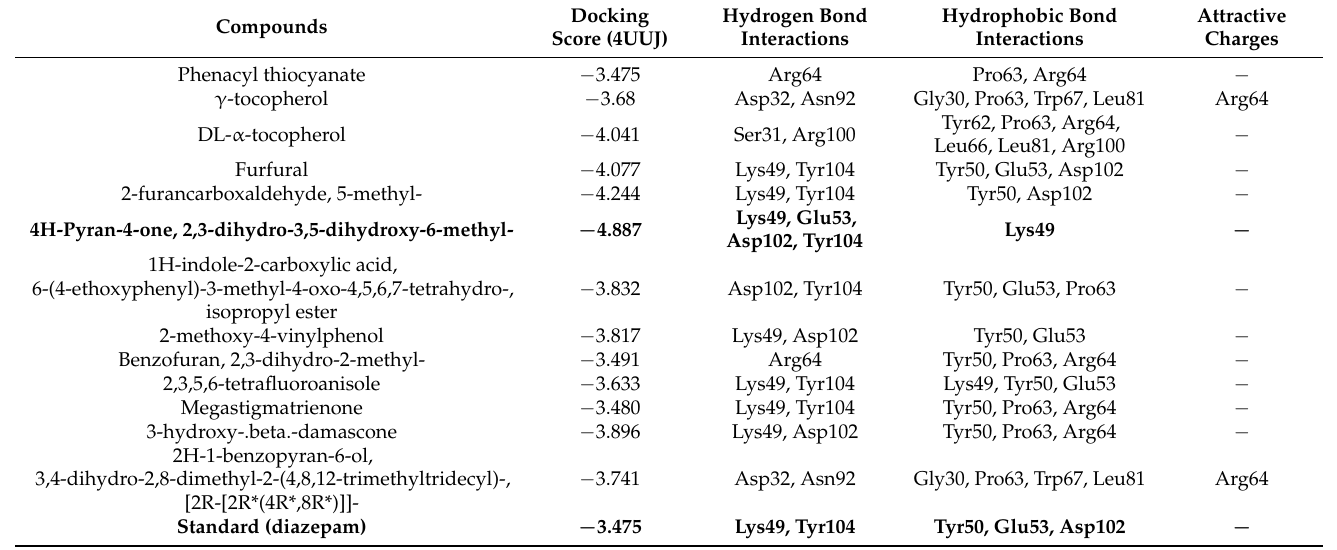
Table 3. The docking scores of selected compounds identified in the methanol extract of Cnesmone javanica against potassium channels receptor (PDB ID: 4UUJ). Bold text indicates the best scores.